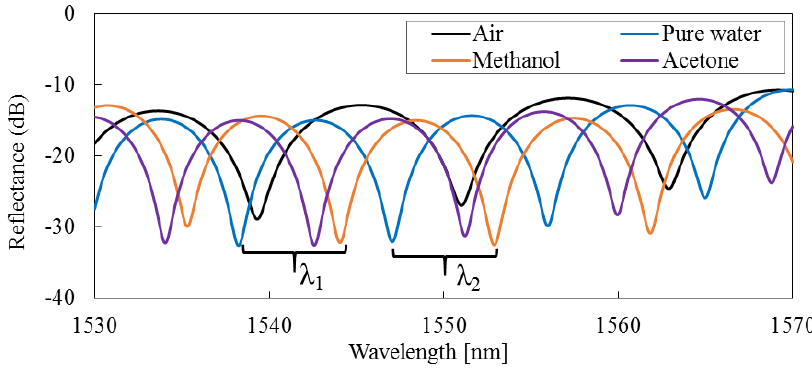
Figure 9. Interference spectra of the fabricated FFPI sensor in air, pure water, methanol, and acetone.